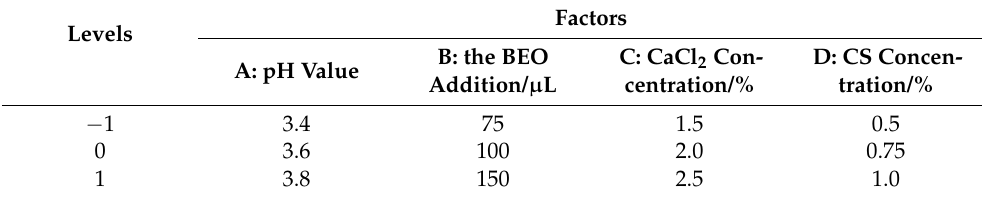
Table 6. Experiment design factors and coding levels.